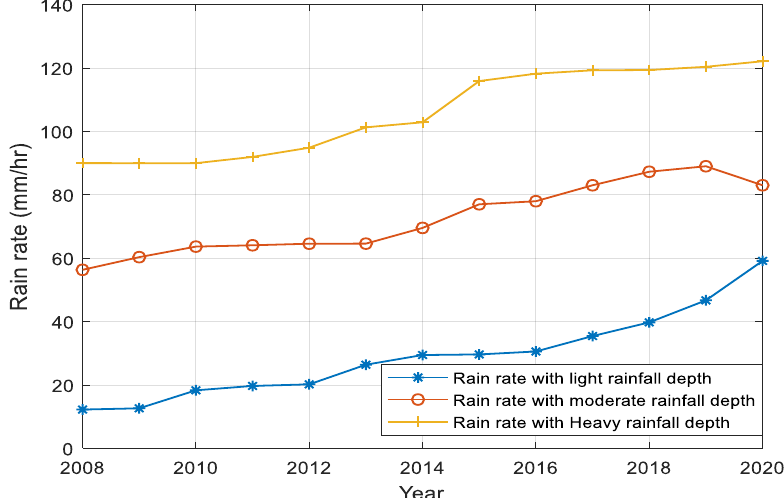
Figure 5. Classified rain rates values based on rainfall depth levels.